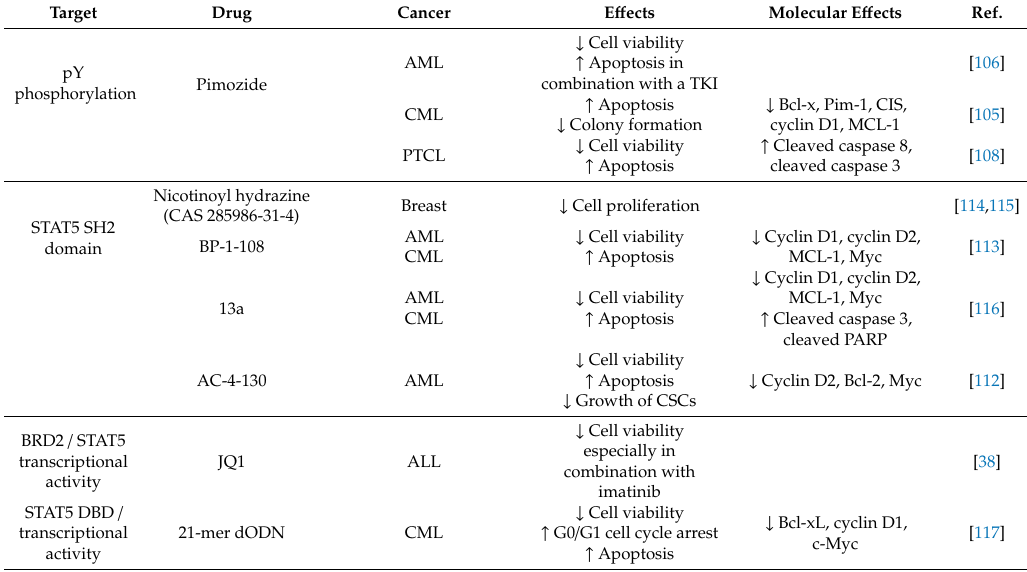
Table 2. A list of selected STAT5